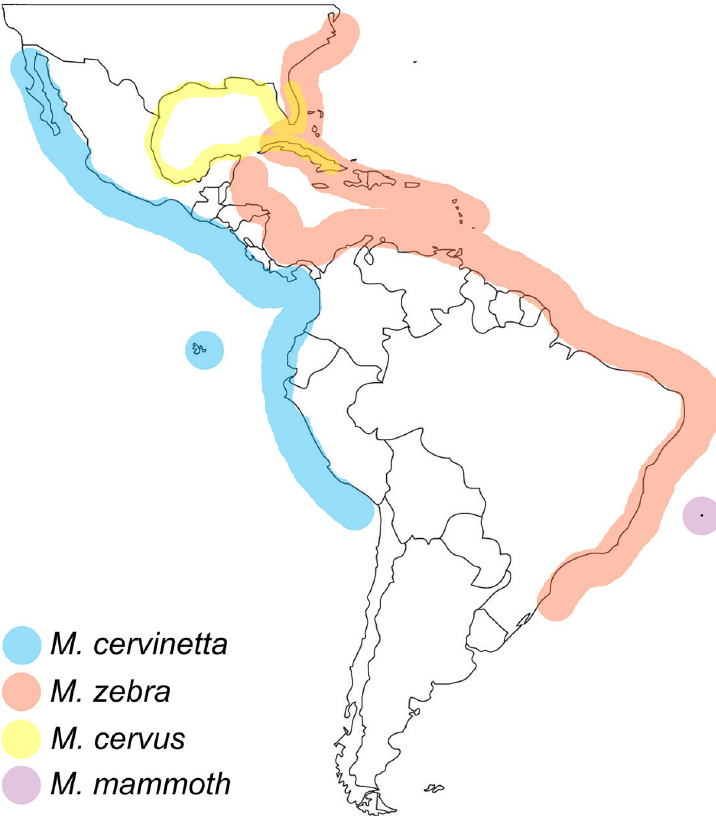
Fig 1. Schematic map of Americas showing approximate extension of the four studied species, color as